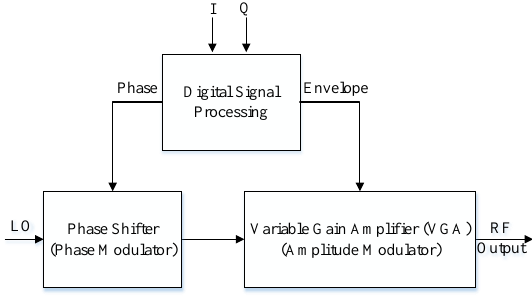
Figure 1. Block diagram of the mixer-less polar transmitter.